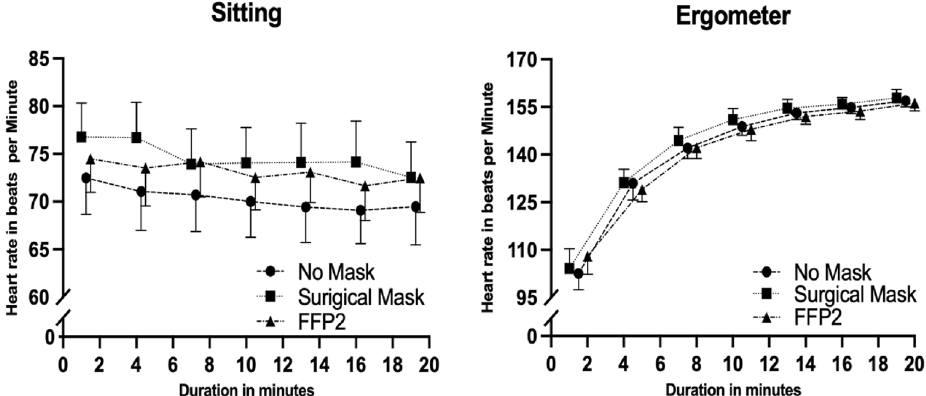
Figure 2. Mean values and 95% confidence intervals of heart rate data of all assessed time points during the sitting and the exercise condition with no mask, a surgical mask and a filtering face piece type 2 (FFP2).